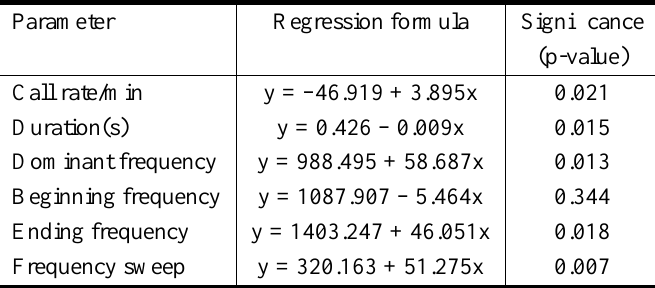
Regression formulae of quantitative call parameters of Leptodactylus fuscus with